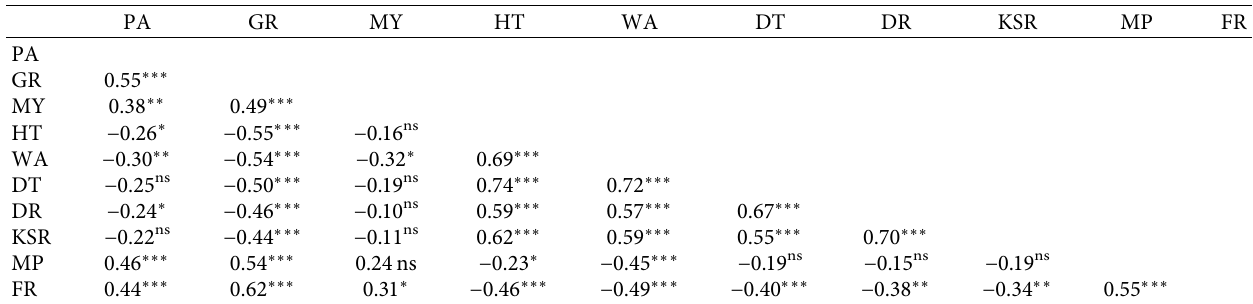
Table 6: Spearman’s rank correlation among important traits.